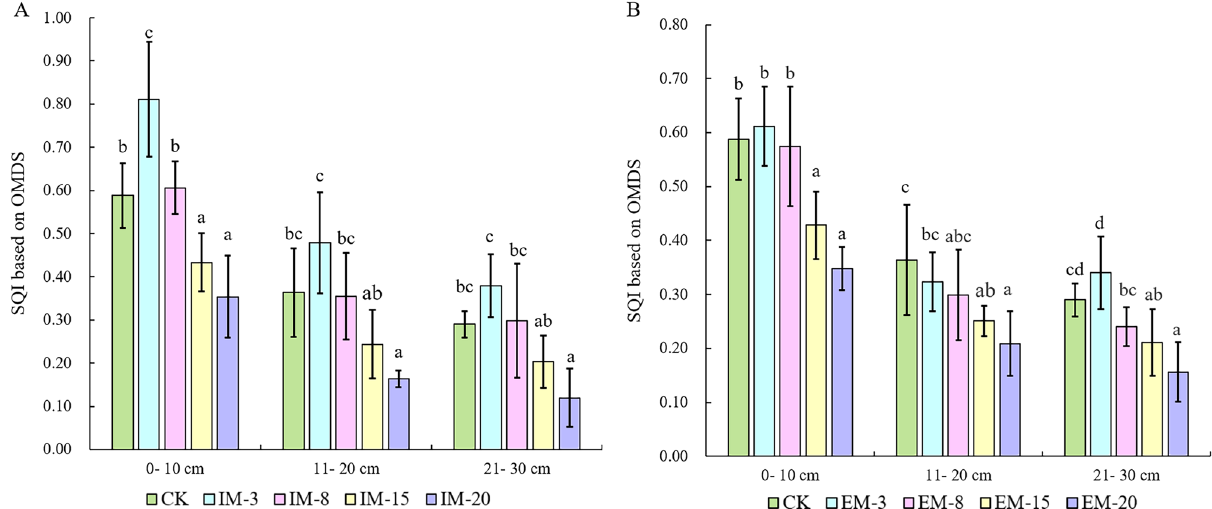
Figure 4. Soil quality index (SQI) of intensive management (IM) and extensive management (EM) C. dabieshanensis forests. There were significant differences in the one-way ANOVA of various compound patterns with different letters (LSD, p < 0.05), and the significance signs are independent for each soil